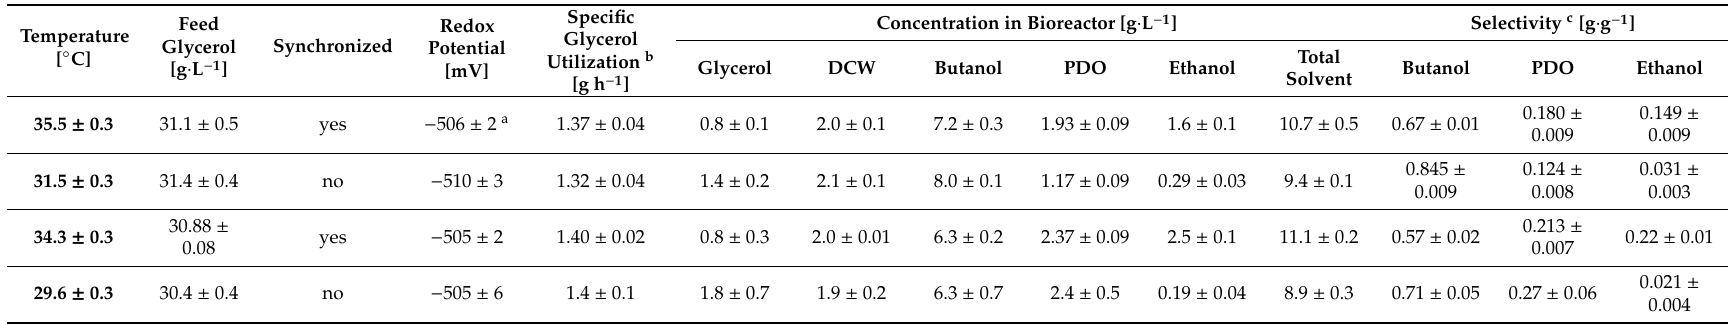
Table 3. Summary of average data for the investigation of the e ff ect of temperature on synchronized oscillatory metabolism at a dilution rate 0.092 h − 1.